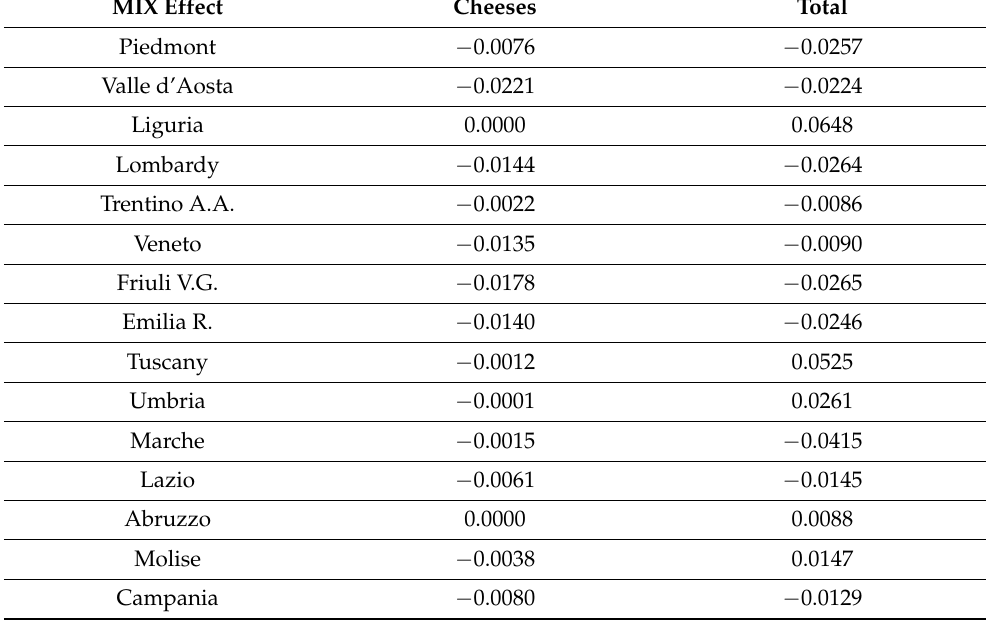
Table 4. Shift and share